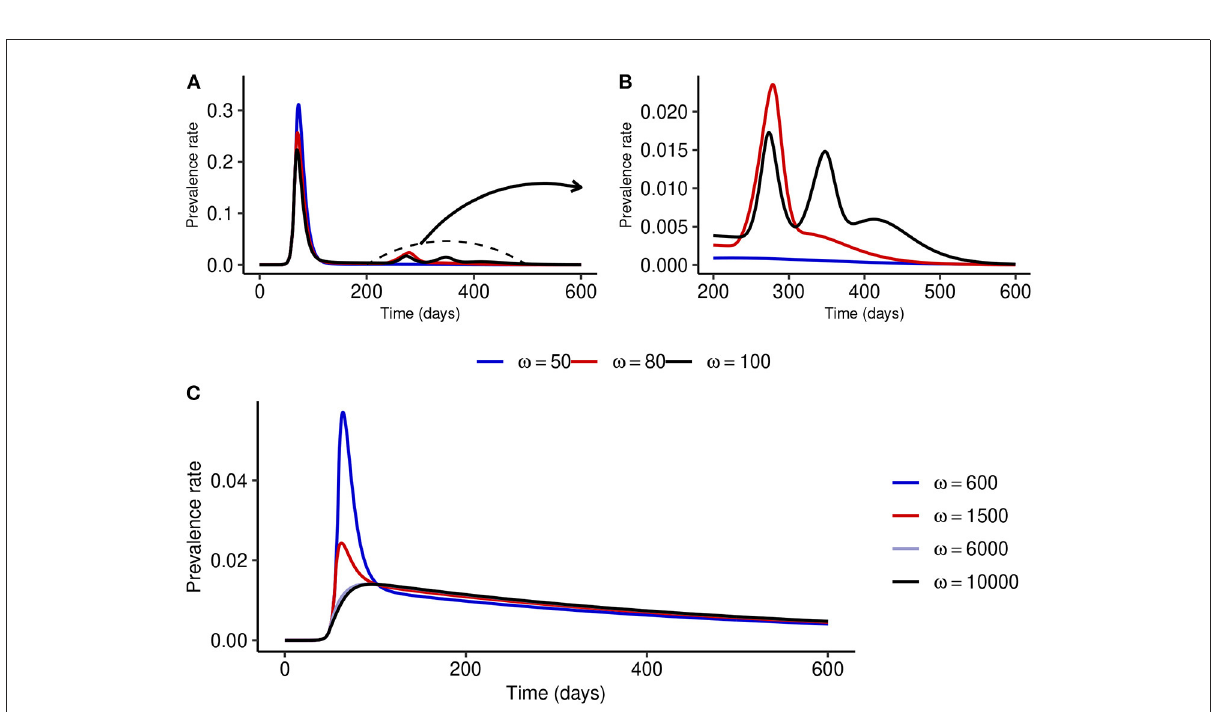
FIGURE4 Effect of increasing ω at fixed medium-level NPI stringency ( α = 500). (A, B) Show that multiple epidemic waves can occur when ω is not high enough. Both the number of secondary waves and the prevalence at each secondary peak depend on the stringency of NPIs, α , and the public tolerance for the disease, 1/ ω . (C) Shows that the epidemic curve can be flattened for considerably high values of ω